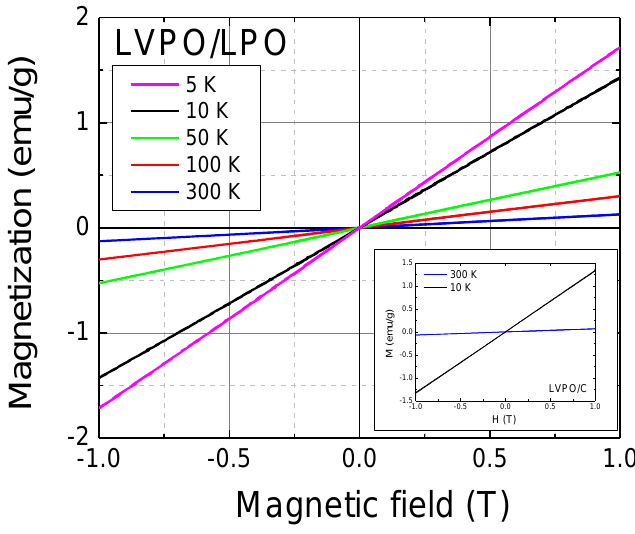
Figure 5. Magnetization as a function of the external magnetic field in the Li 3 V 2 (PO 4 ) 3 /Li 3 PO 4 composite at different temperatures. Inset shows data for Li 3 V 2 (PO 4 ) 3 /C.